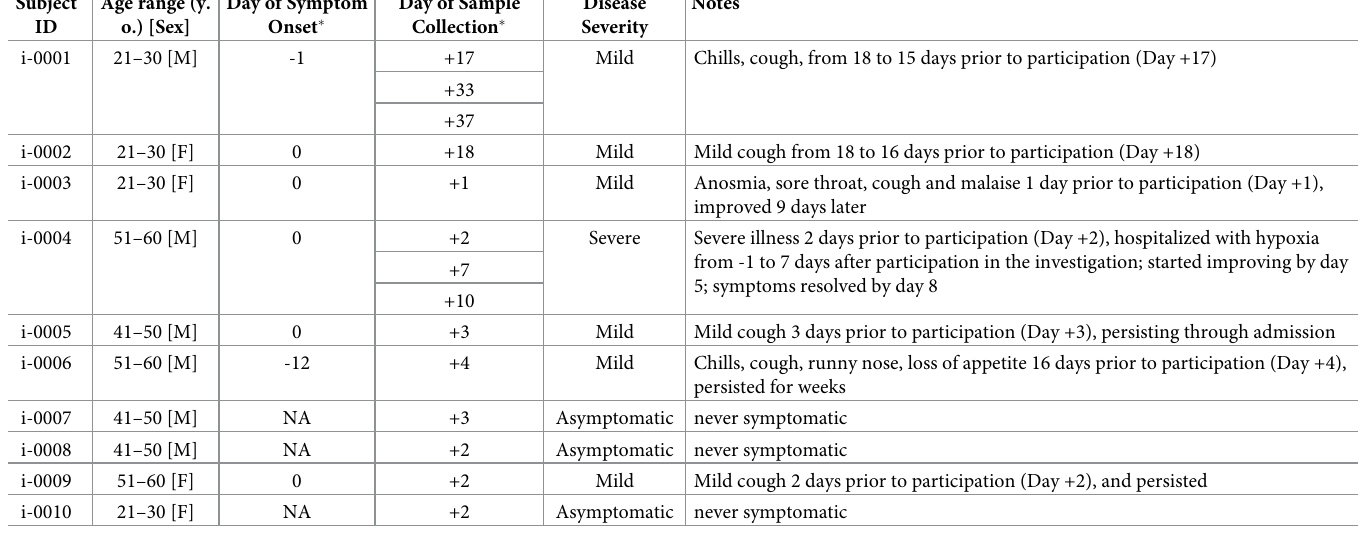
Table 1. Summary of COVID-19